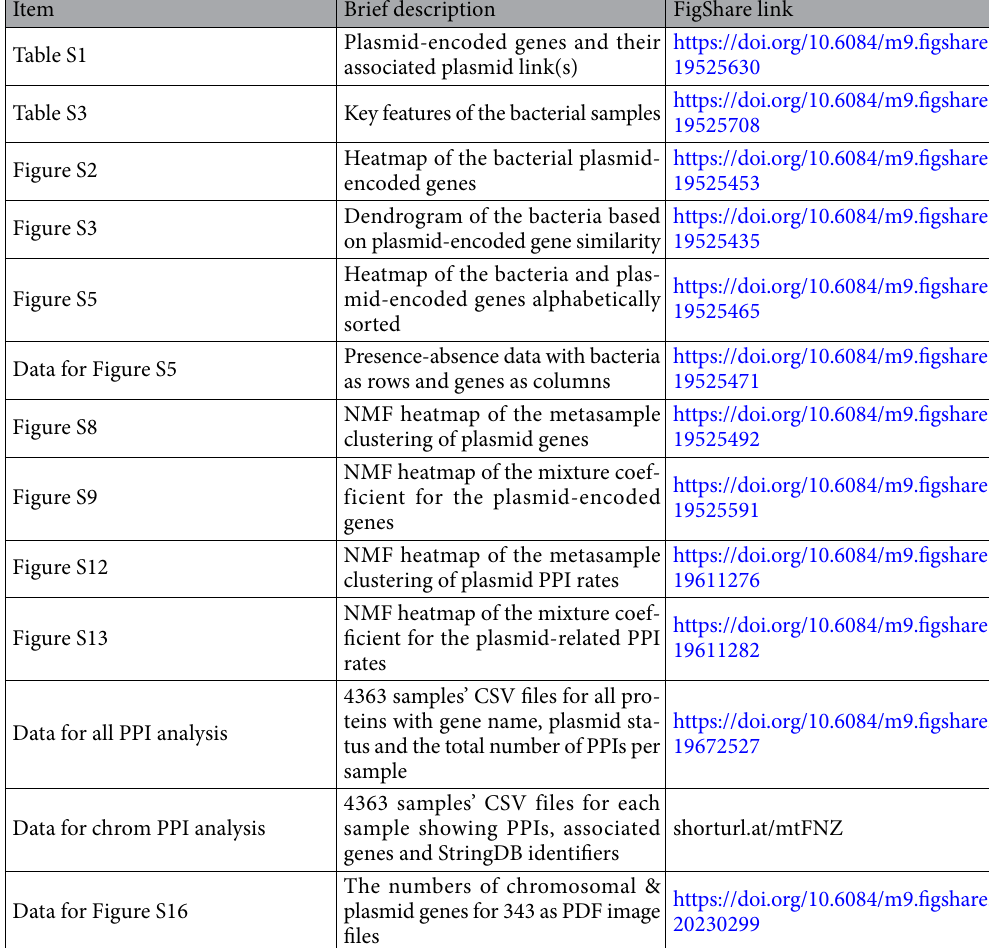
Figure S2 Figure S3 Figure S5 Data for Figure S5 Figure S8 Figure S9 Figure S12 Figure S13 Data for all PPI analysis Data for chrom PPI analysis Data for Figure S16